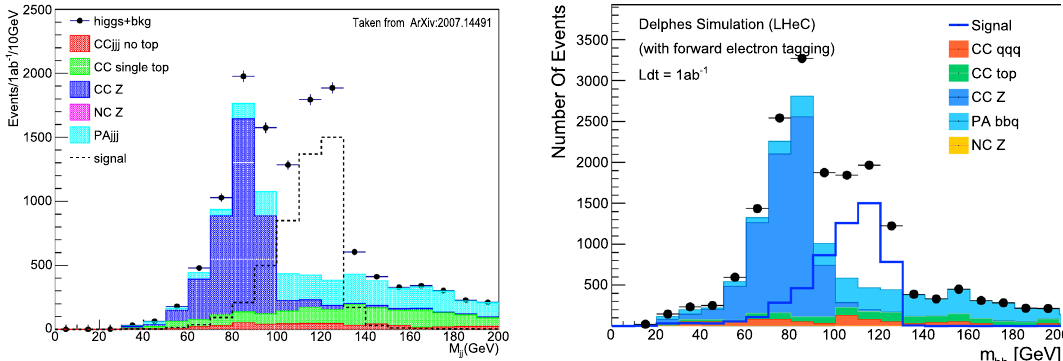
Fig. 3 The invariant di-jet mass of two selected b -tagged jets of the updated LHeC CDR [2] (left) and the Delphes analysis of our study (right) for the LHeC setup